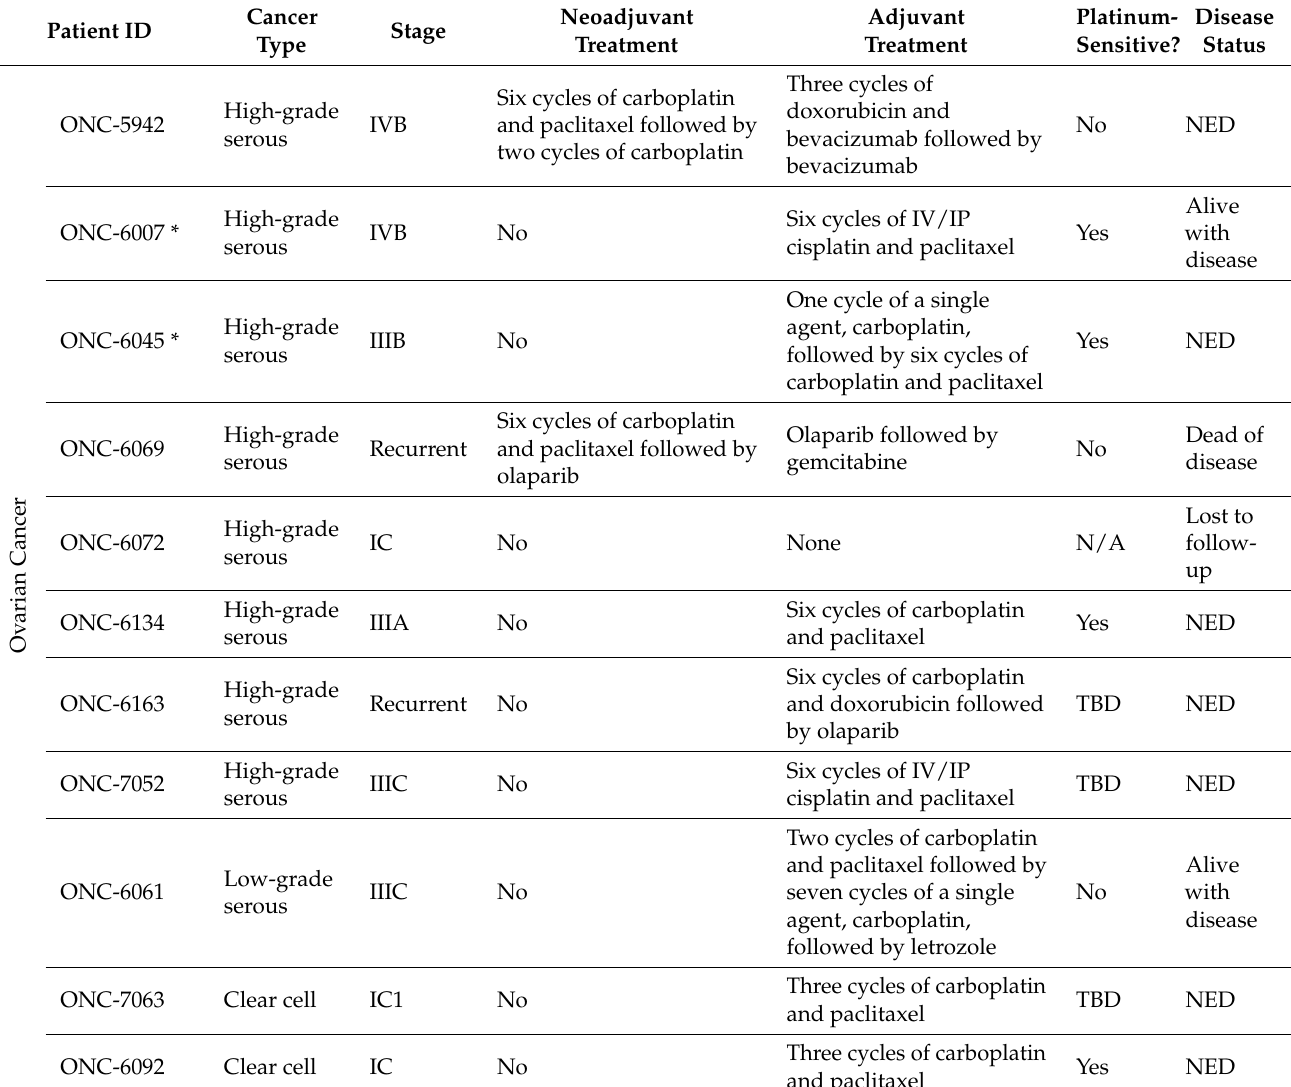
Table 1. Patient and tumor characteristics corresponding to the 19 PDOs used for drug screening studies. IV: intravenous; IP: intraperitoneal; NED: no evidence of disease; N/A: not available; TBD: to be determined; * indicates the PDOs that were generated using the ascites fluid